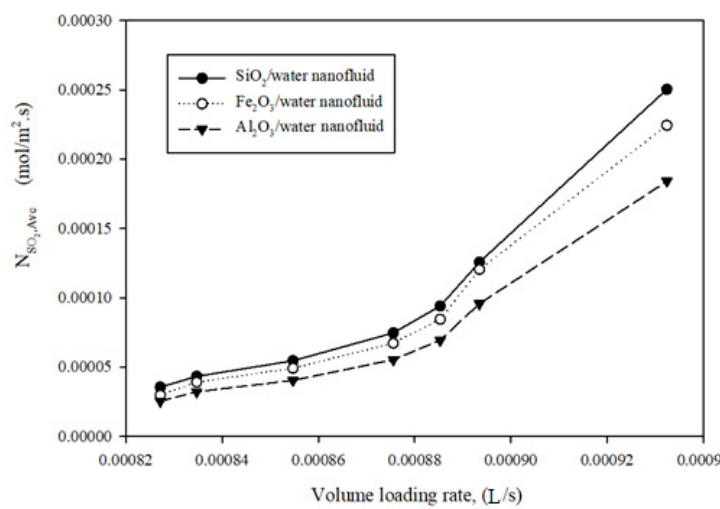
Processes 2019 , 7 , x FOR PEER REVIEW Figure 7. Average molar flux of CO 2 versus volume loading rate. Figure 7. Average molar flux of CO 2 versus volume loading rate.